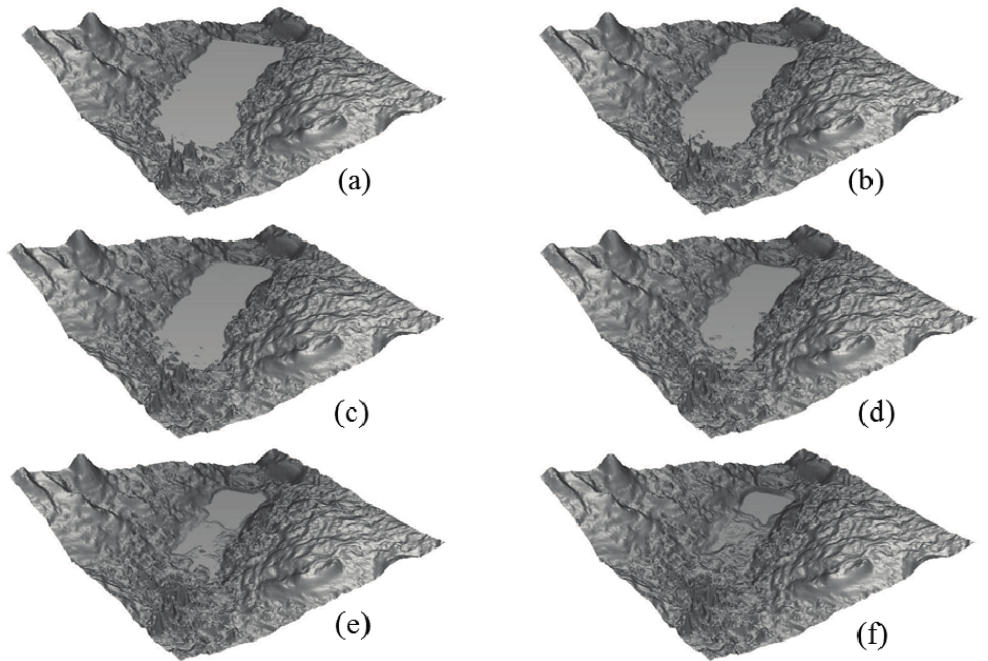
Figure 4. Laaba basin, 3D representation of the DEM used for SAR simulation. Water contour height: 341 m ( a ), 340.5 m ( b ), 340 m ( c ), 339.5 m ( d ), 339 m ( e ) and 338.5 m ( f ). A vertical stretching factor has been applied for visualization